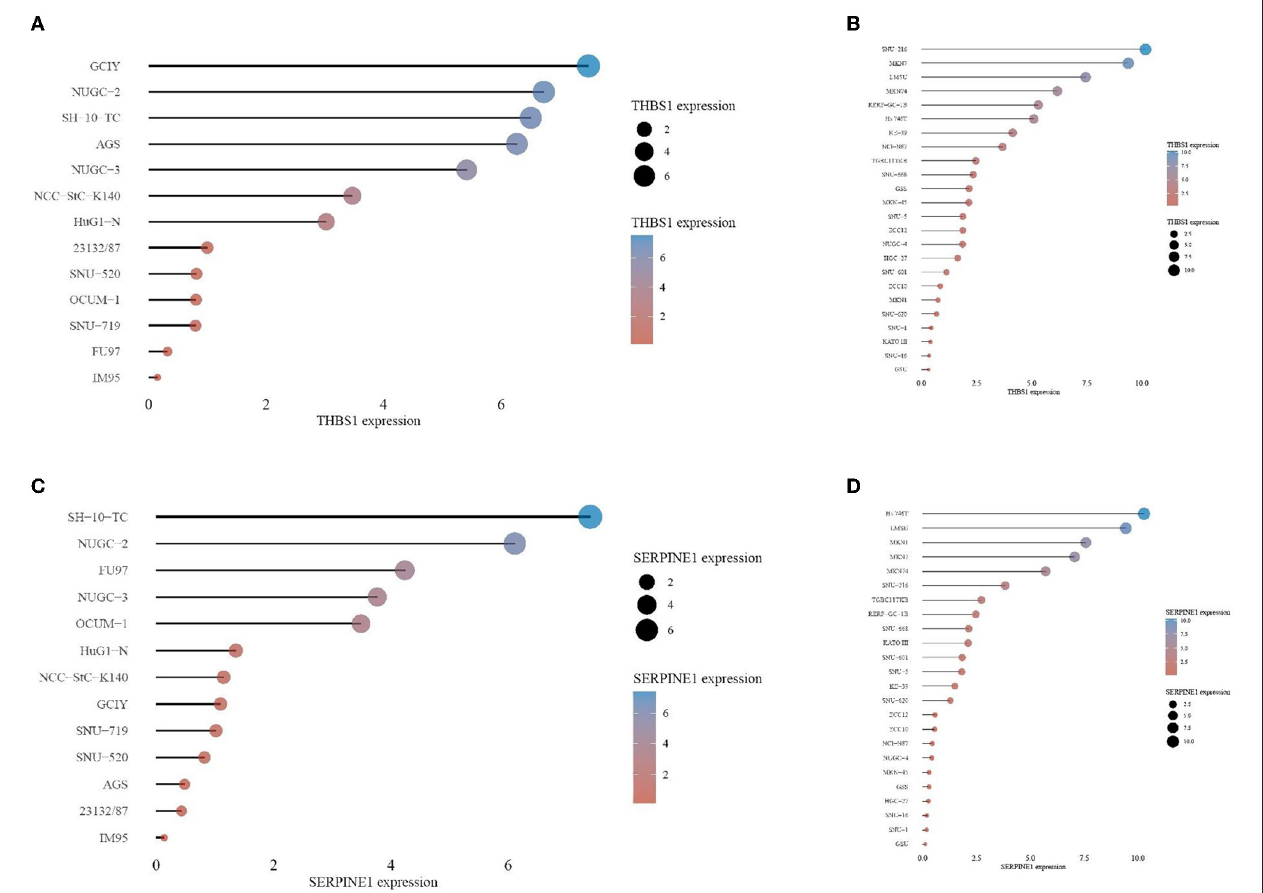
FIGURE 10 | Gene expression levels in different gastric cancer cell lines for (A) THBS1 in primary cancer cell, (B) SERPINE1 in primary cancer cell, (C) THBS1 in metastasis cancer cell, and (D) SERPINE1 in metastasis cancer